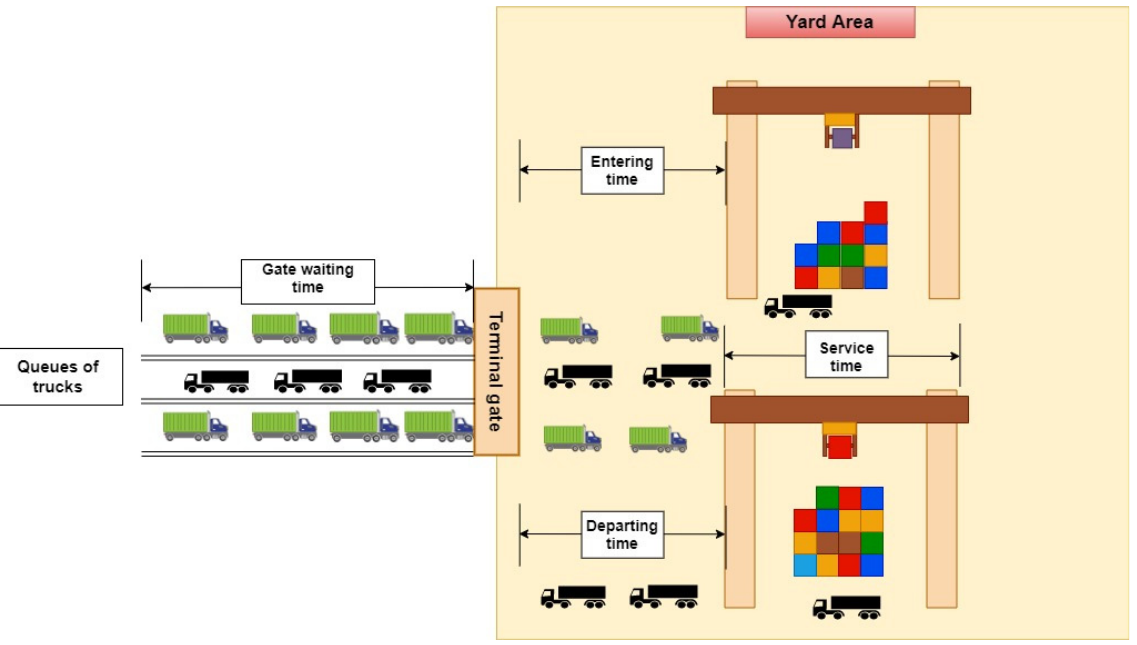
Figure 3. The times spent by trucks to perform the different tasks of container